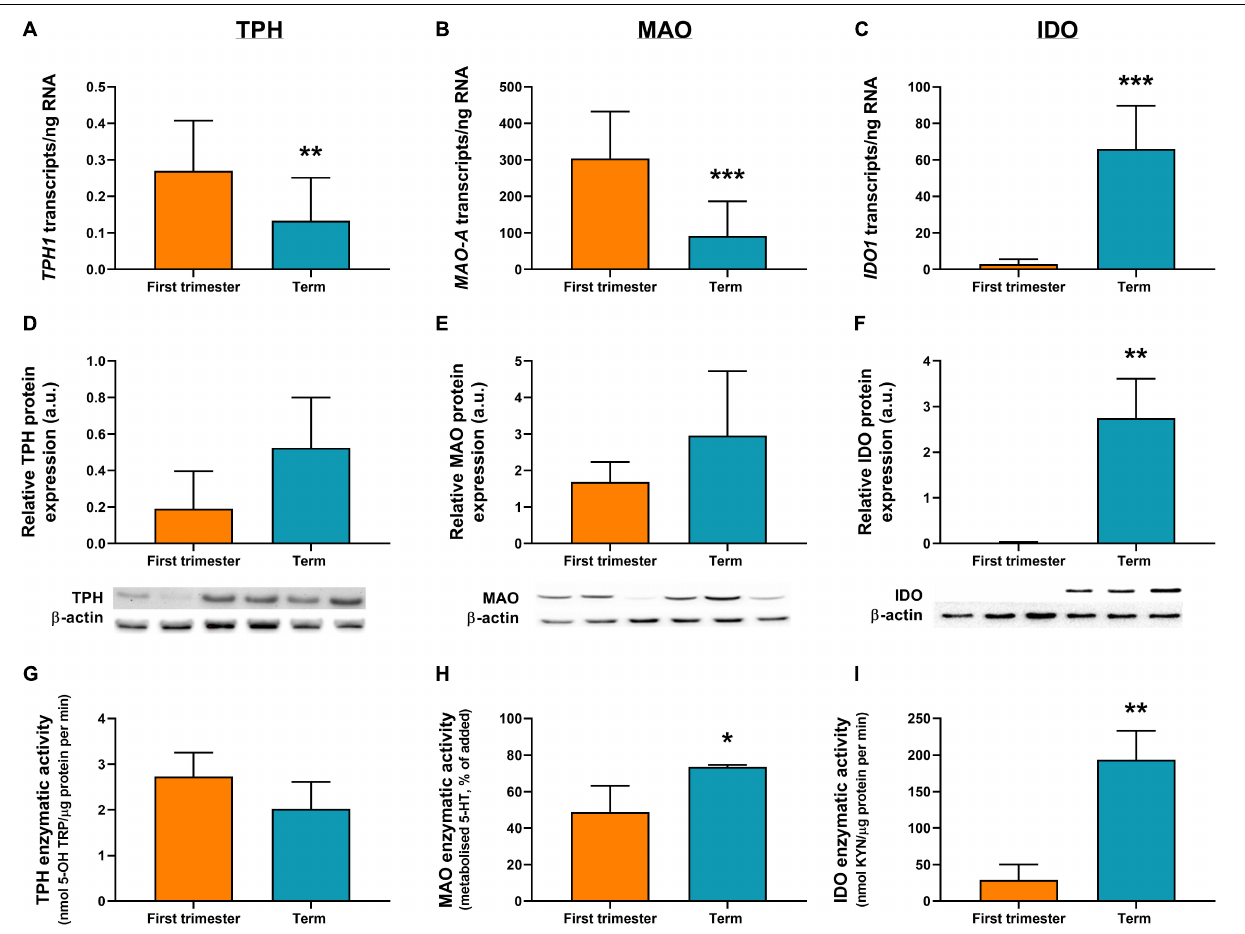
FIGURE 3 | Gene/protein expression and functional analyses of the rate-limiting enzymes of 5-HT and KYN pathways. Expression and function of tryptophan hydroxylase-1 ( TPH1 /TPH1), monoamine oxidase-A ( MAO-A /MAO-A), and indoleamine 2,3-dioxygenase-1 ( IDO1 /IDO1) between the first-trimester and term human placenta was analyzed by digital droplet PCR (A–C) , Western blot (D–F) , and enzymatic activity (G–I) analyses. Protein expression was normalized to β -actin as a loading control; representative immunoblots for target proteins and β -actin are shown. For ddPCR analysis n = 13 (first trimester) and n = 25 (term placentas); for protein/functional analysis n = 3 for each. Data are presented as mean ± SD and statistical significance was evaluated using unpaired t -test; * p ≤ 0.05, ** p ≤ 0.01, *** p ≤